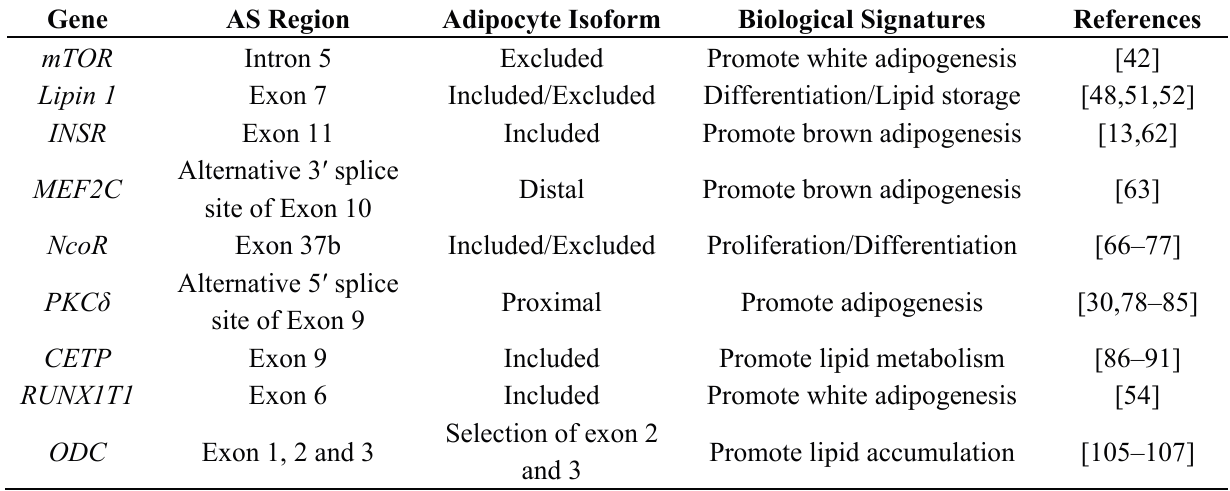
Table 2. Exon usage and biological relevance of adipocyte-related AS